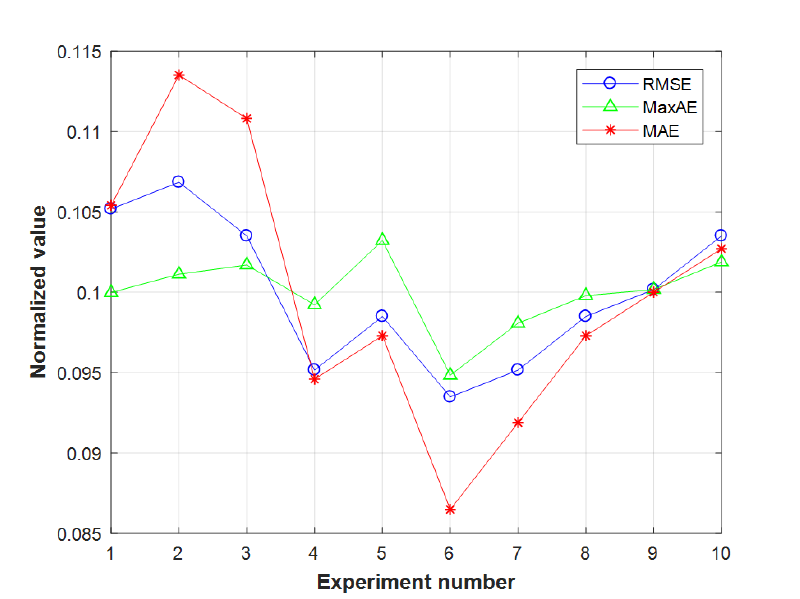
Figure 10. The fault prognosis results of CDBN models with different network structures.